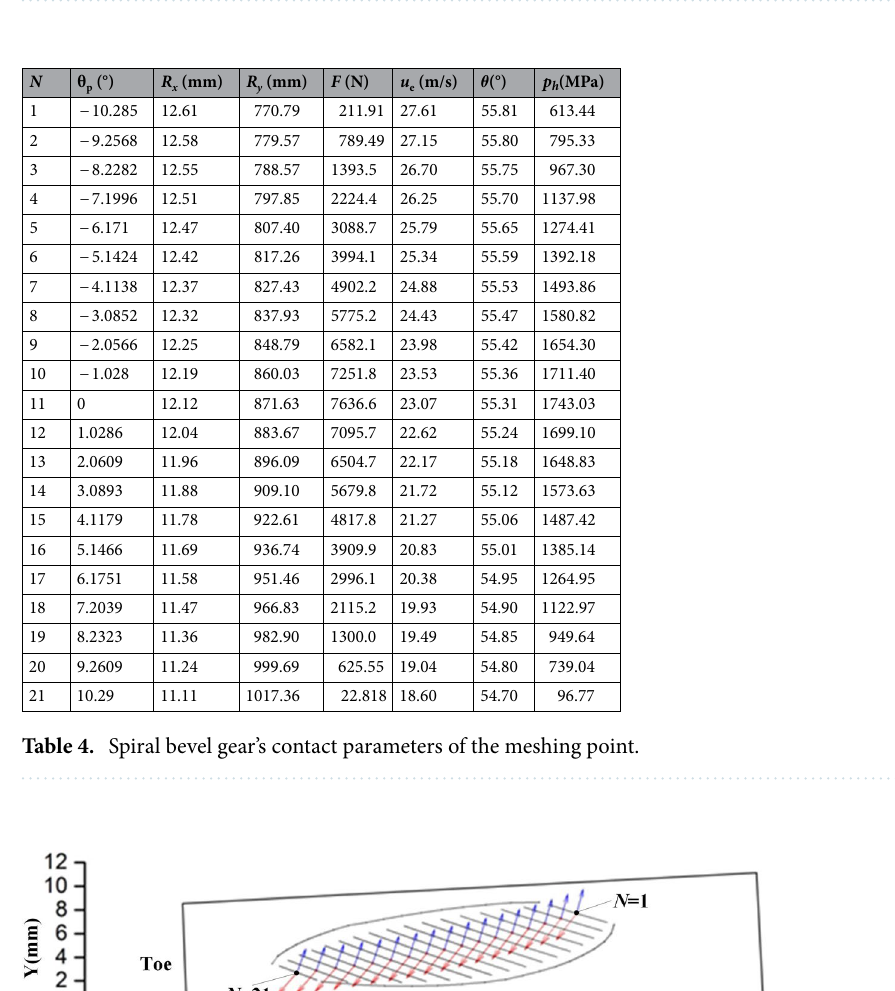
Table 3. Material parameters and lubricating oil characteristics of spiral bevel gears.